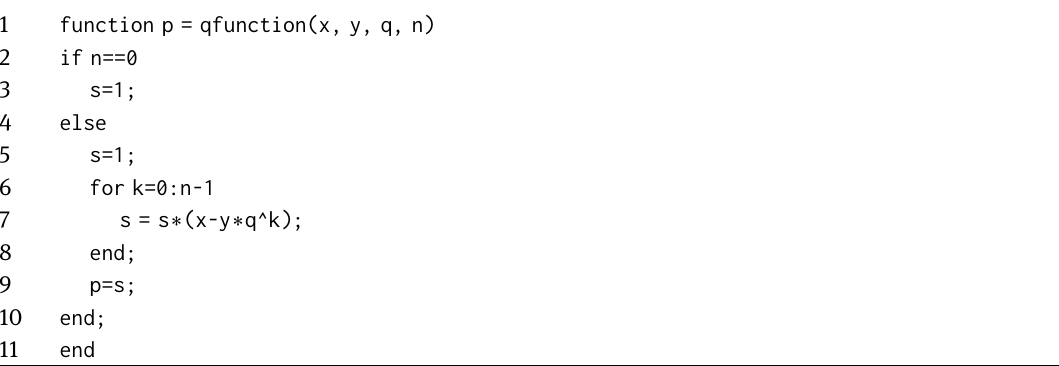
Algorithm 1. MATLAB lines for calculation of q - factorial function